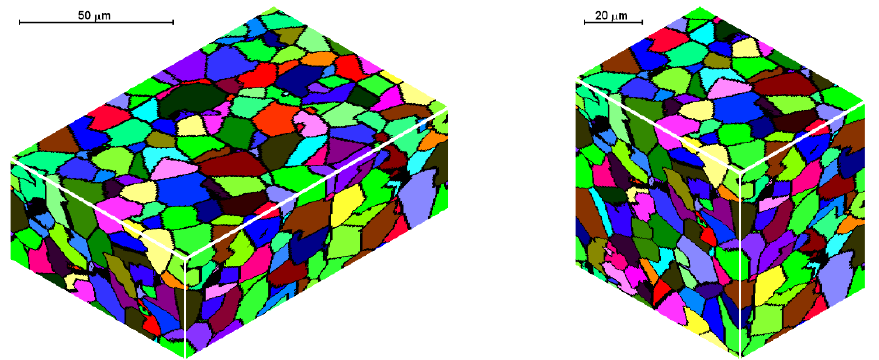
Figure 12. Reorganization of space by cutting and bonding.